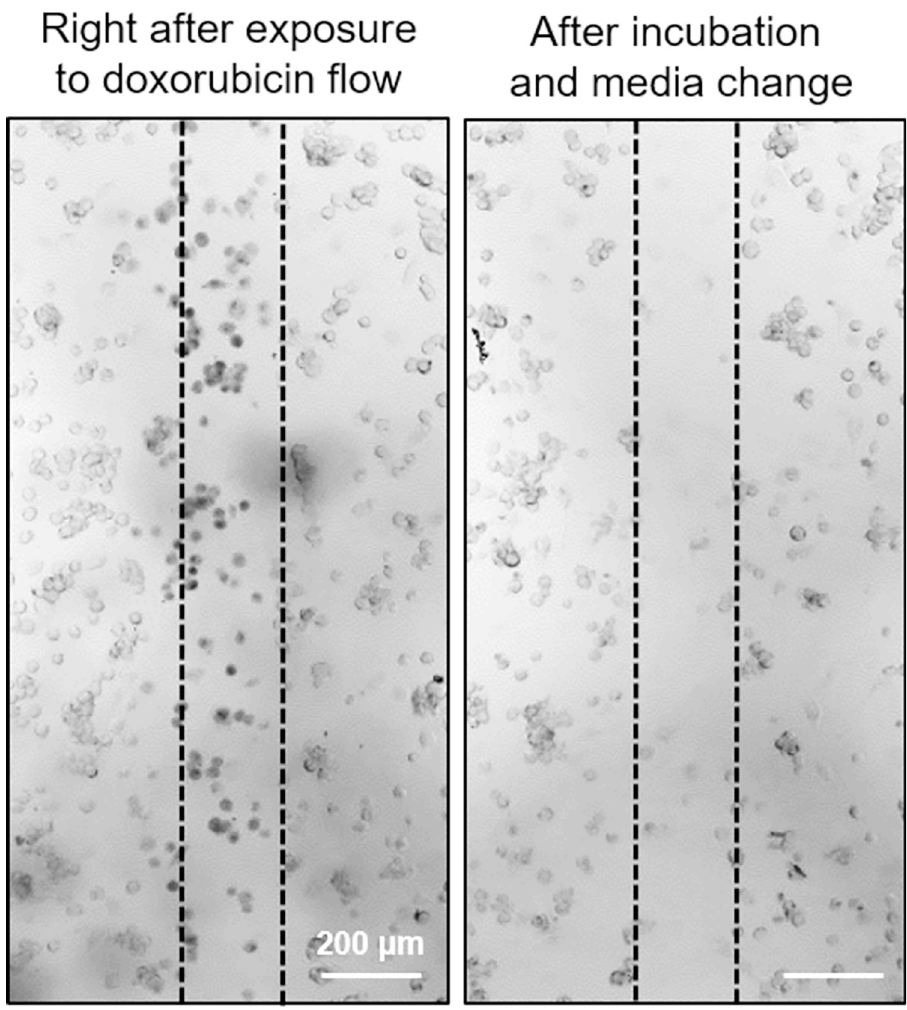
Fig 6. Cytotoxicity assay of doxorubicin on spatially selected 4T1 cells in the HFSM device. Brightfield microscope images of 4T1 cells in the culture chamber immediately after a 10 min exposure to a doxorubicin stream (left) and after a subsequent 12 hr incubation and one time media change (right). The area between the black dashed lines indicates the path of the doxorubicin stream.